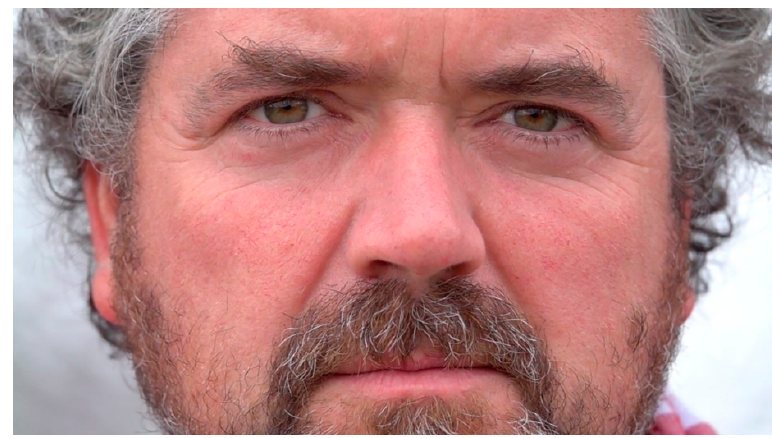
Figure 4. Dalziel + Scullion, still from “Sàl”, 2018. Image courtesy of Dalziel + Scullion.